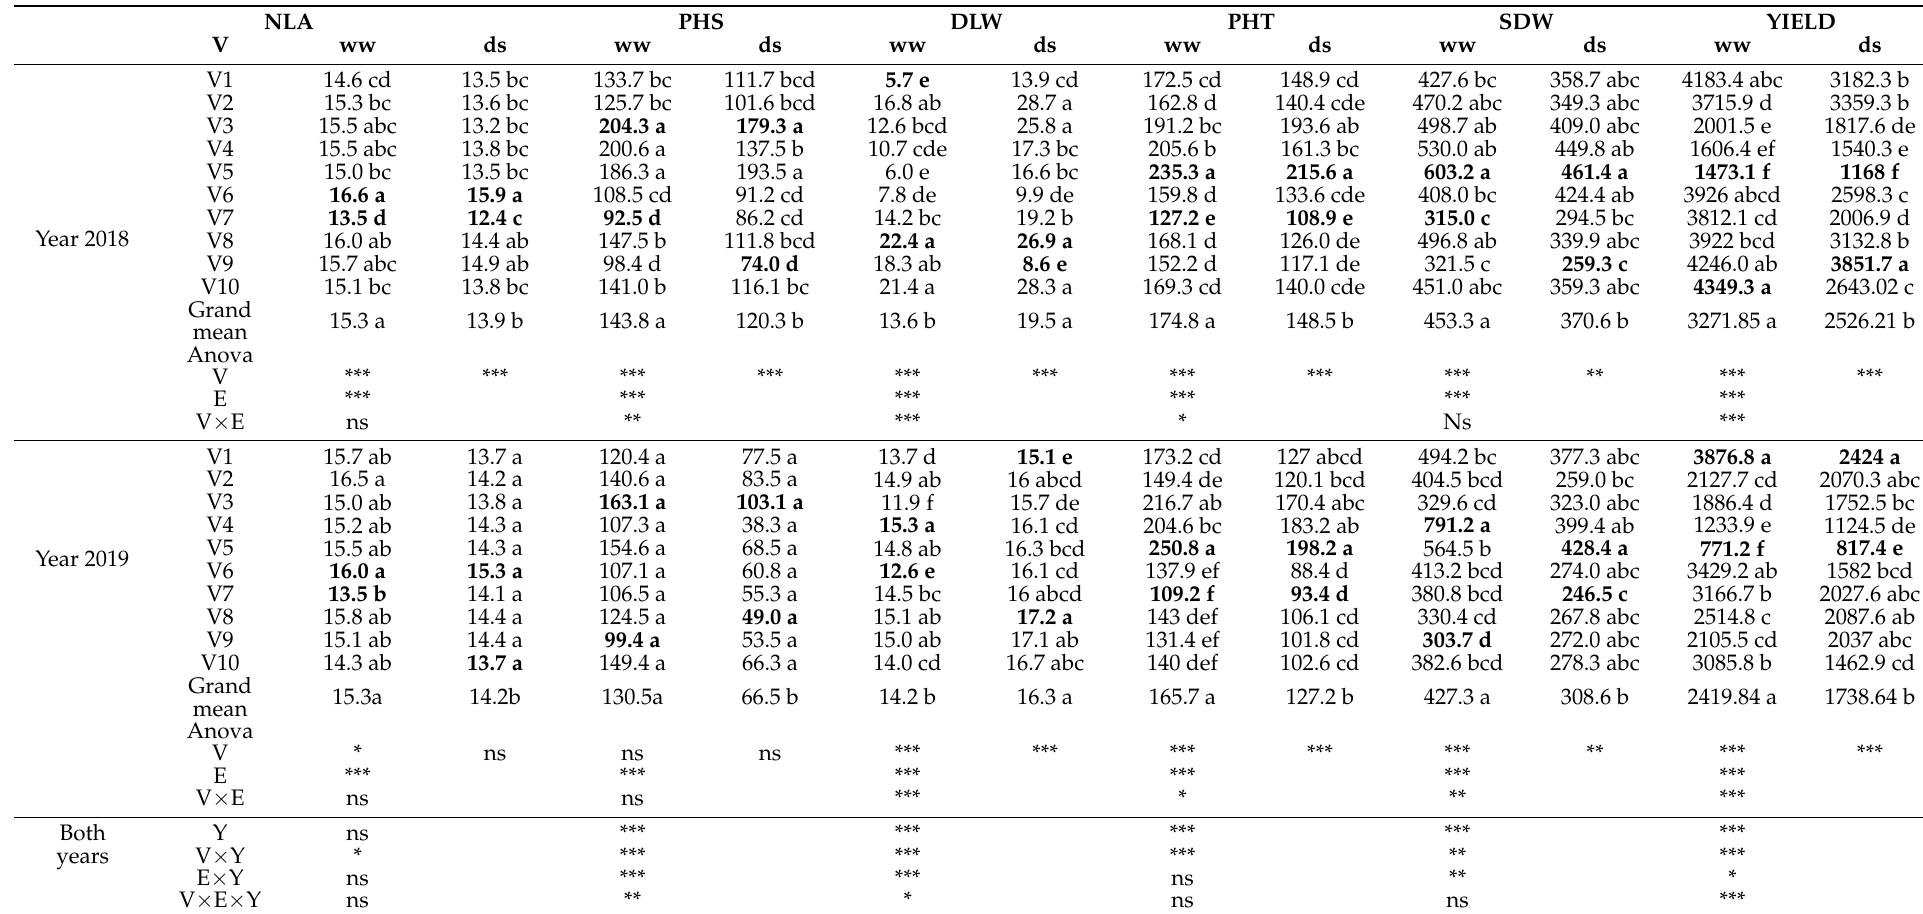
Table 4. Variety and environment per se performance compared among ten sorghum varieties and two water treatments (well-watered and drought stress) for morphological traits measured during 2018 and 2019 field